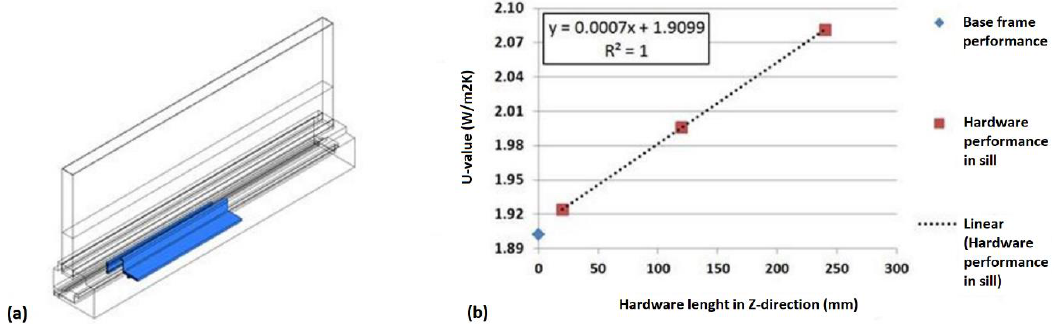
Figure 7. An example 240 mm long hardware configuration in full sill geometry ( a ), and total frame U-value as a function of hardware length ( b ).